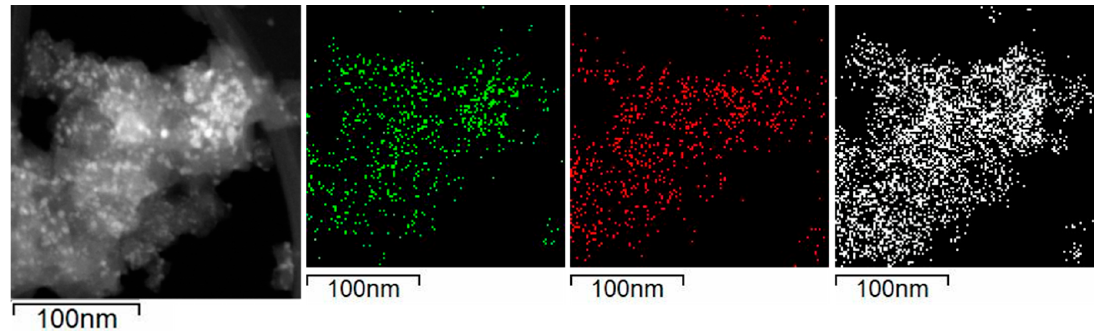
Figure 13. Selected area for the EDX mapping for used Ni / Ca(19.3)-SiO 2 catalyst; mapping of nickel (green), calcium (red), and silicon (white).